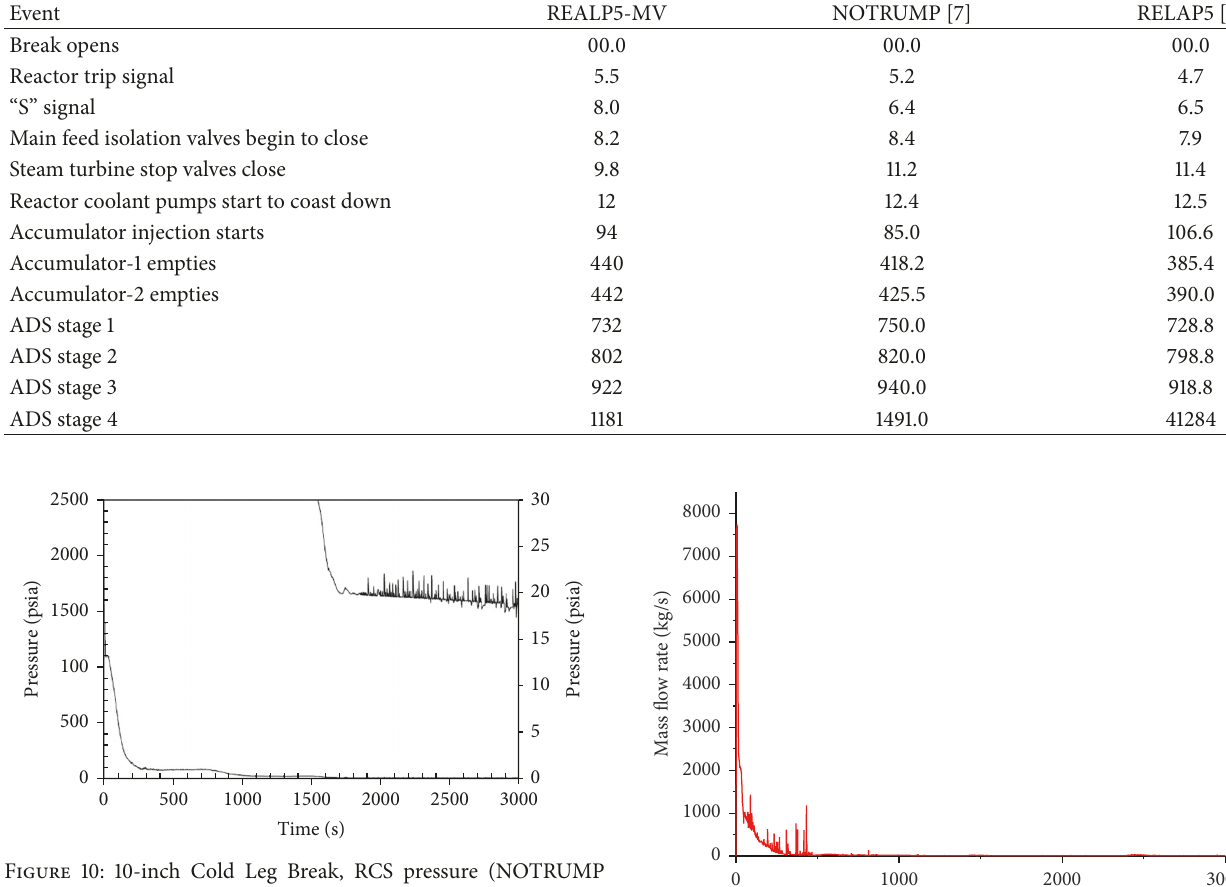
Figure 10: 10-inch Cold Leg Break, RCS pressure (NOTRUMP code) [7].